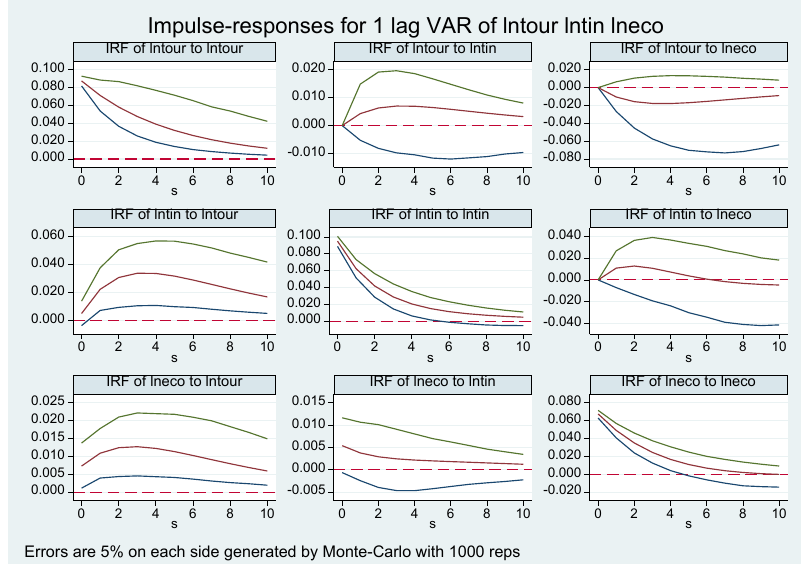
Figure 3. Impulse responses of the tourism industry, technological progress, and ecological economy development of China. The red lines represent estimated impulse response value. The area between the green lines and blue lines is the confidence interval of 5% significance.